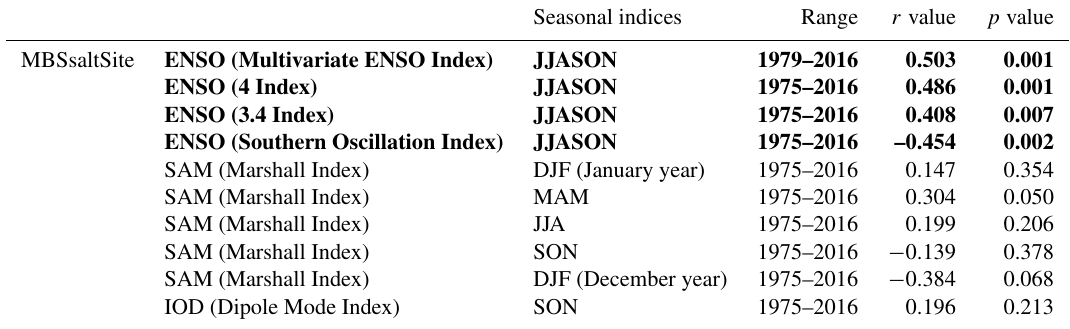
Table A1. Pearson’s correlation coefficient for the detrended annual log-transformed sea salt concentrations (sodium) for the Mount Brown South site average (MBSsaltSite) against detrended seasonal ENSO, SAM, and IOD indices. Correlations significant at 95% are shown in bold, and the dates range between 1975–2016. Where sodium concentrations were below detectable levels for ion chromatography, chloride concentrations were used with adjusted sea water ratios (six samples in the LD sodium record were below detectable